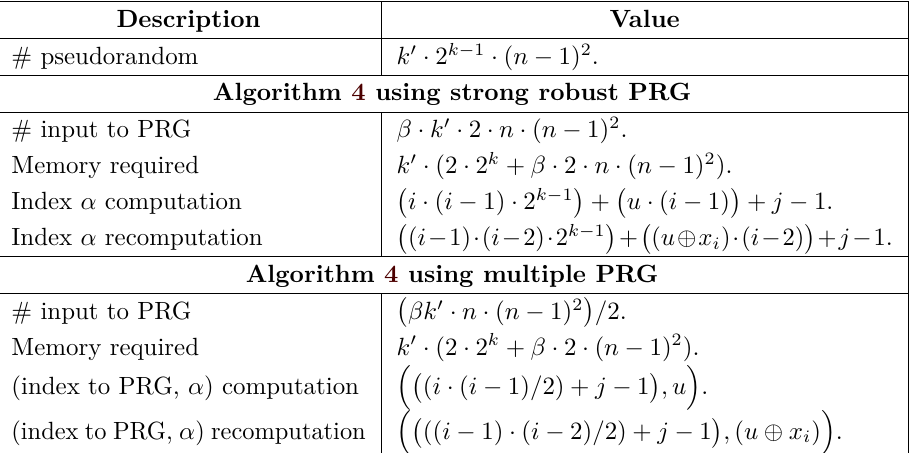
Table 3: Summary of the total number of bits of pseudorandom values the true random values, the number memory required per ( k, k 0 ) S-box along with the formulas for the com- putation and the recomputation of index α for the increasing shares variant of Algorithms 7 and 8 using the robust PRG and the multiple PRG approaches, respectively. Here, i represents the shift index, u is the row index and j represents the column index.